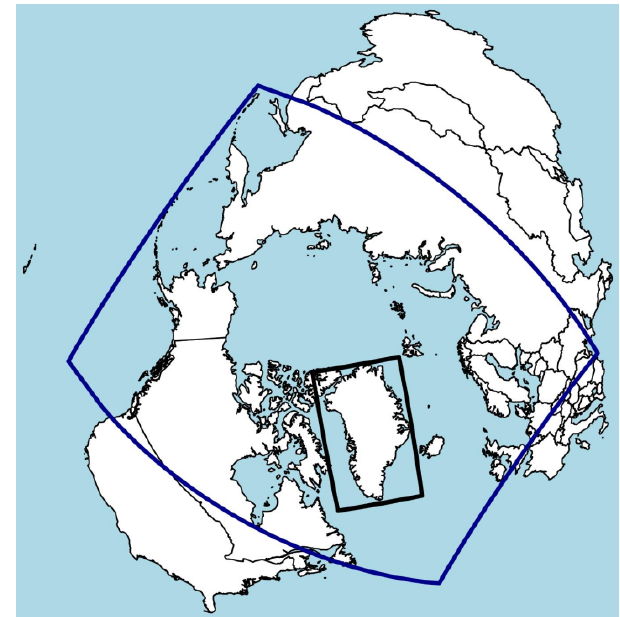
Figure 1. COSMO_iso model domain of the 50km (blue) and the 7km (black) simulation.